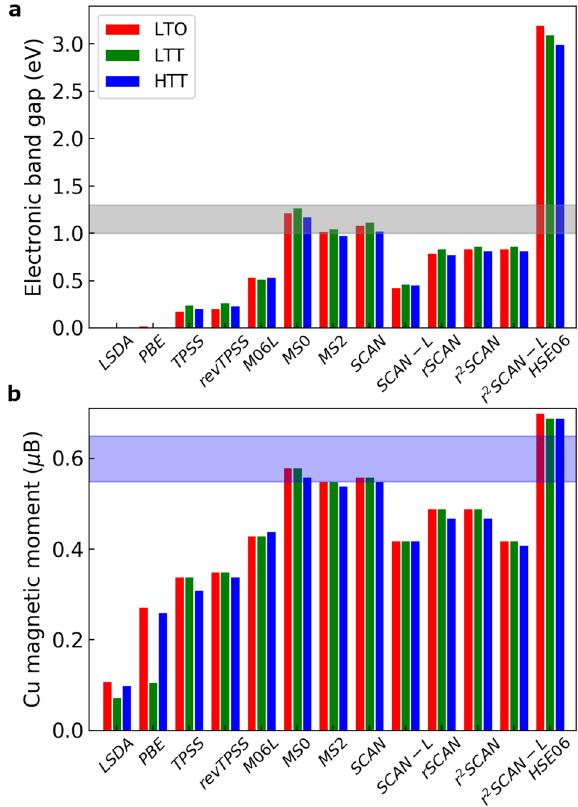
Fig. 5 Band gap and magnetic moment values from various DFAs. Theoretical predicted values of a electronic bandgap and b copper magnetic moment for all three phases of pristine LCO obtained within various density functional approximations. The gray shaded region in a gives the spread in the reported experimental values for the leading edge gap 63 – 65 . In b , the blue shaded region represents the experimental value of magnetic moment 7 . The LSDA and PBE values are taken from ref. 22